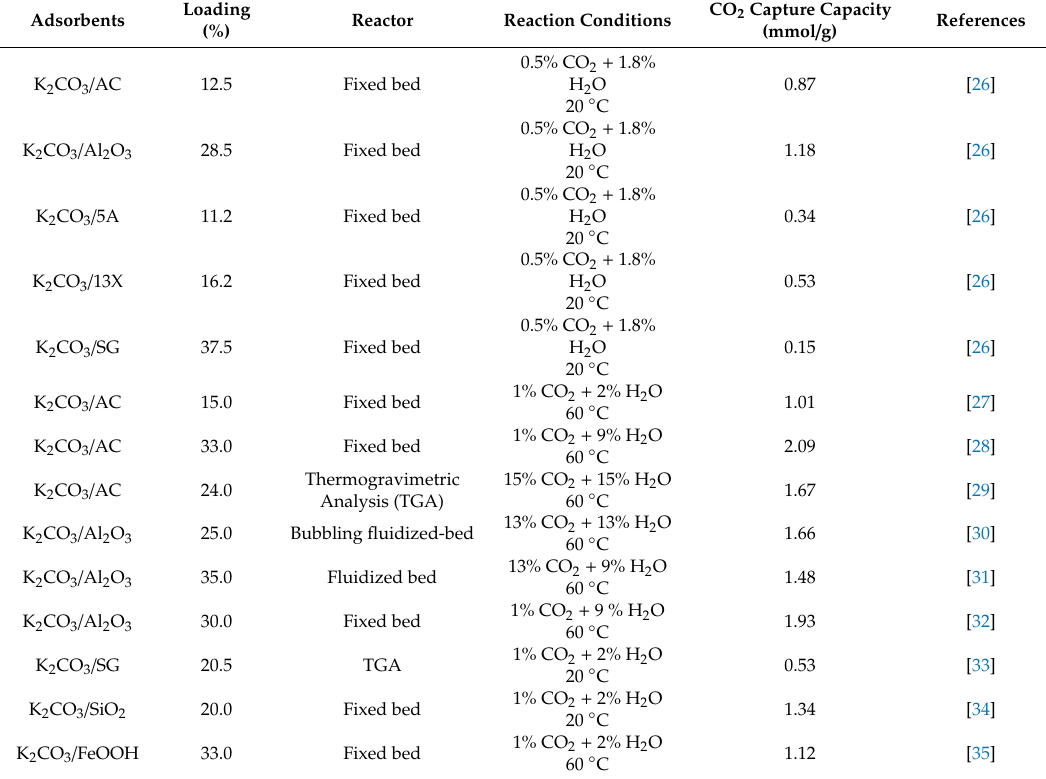
Table 1. A summary of adsorption capacity of potassium-based